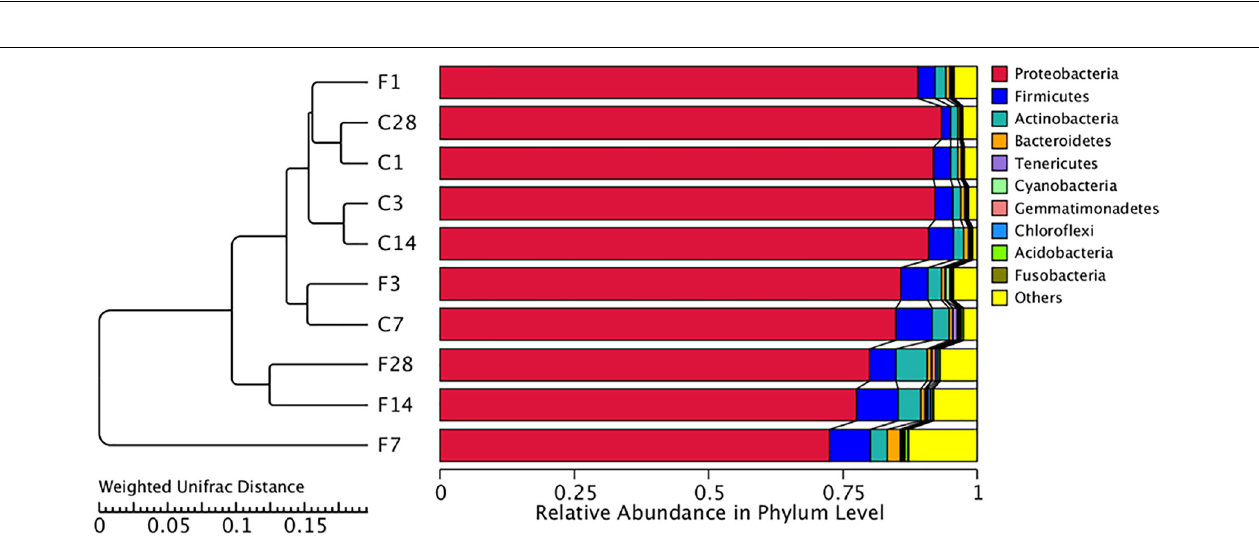
FIGURE 3 | Comparison of Shannon Index based on the genera profile in different groups (C, the group treated with saline; F, the group treated with influenza virus; the number followed C/F represented the day post inoculation). There were 5–6 mice in each group, and each sample was analyzed independent ( ∗ p < 0.05, ∗∗ p < 0.01, and ∗∗∗ p < 0.001, NS no significant compared with CON).